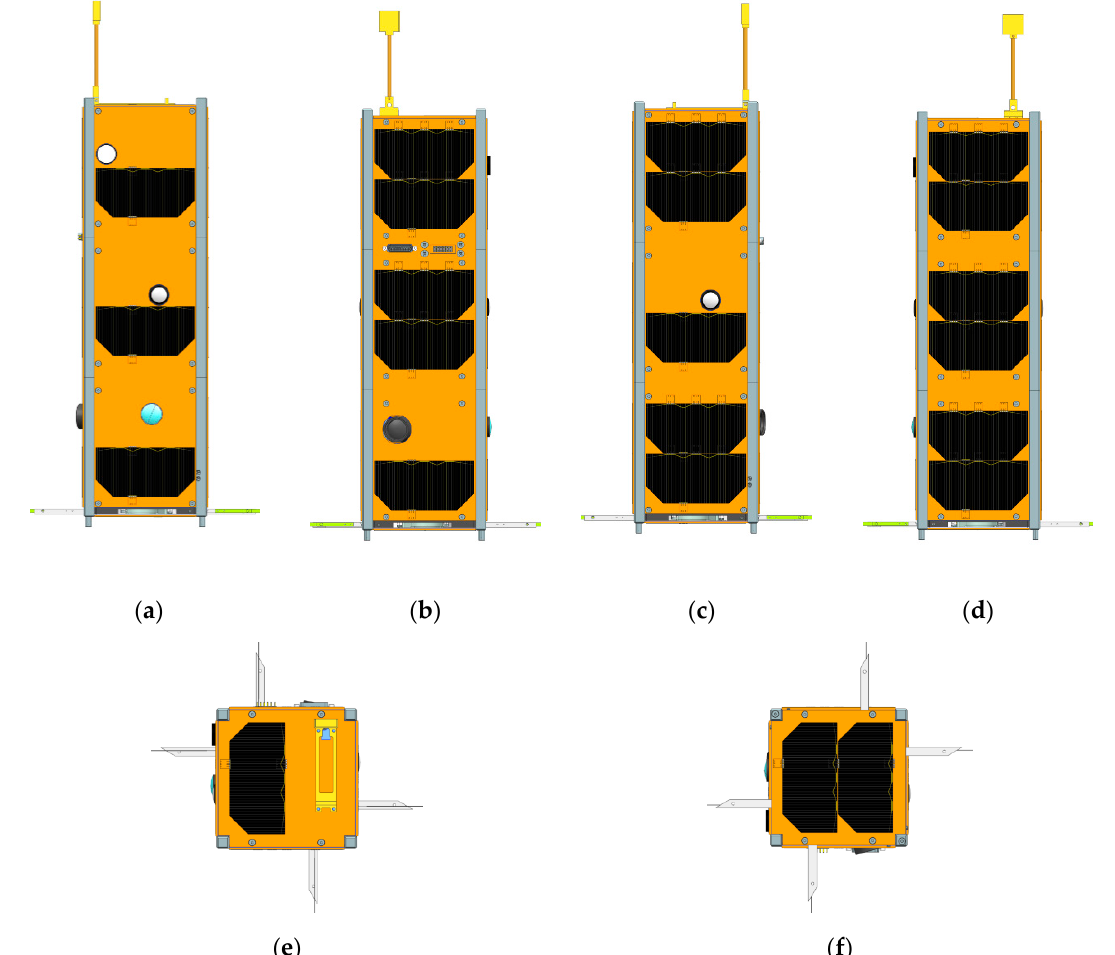
Figure 10. The solar cells distribution around the satellite structure: ( a ) +Z-axis; ( b ) +Y-axis; ( c ) − Z-axis; ( d ) − Y-axis; ( e ) +X-axis; ( f ) − X-axis.